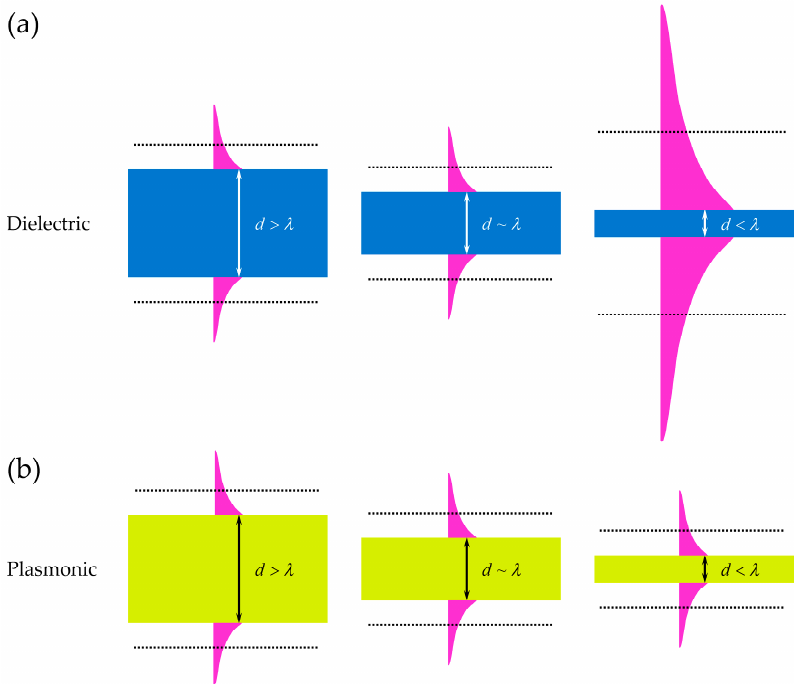
Figure 6. Schematics illustrating the light confinement of ( a ) dielectric versus ( b ) plasmonic waveguides for various core diameters. The dotted lines approximately indicate the 1/e level of the field.